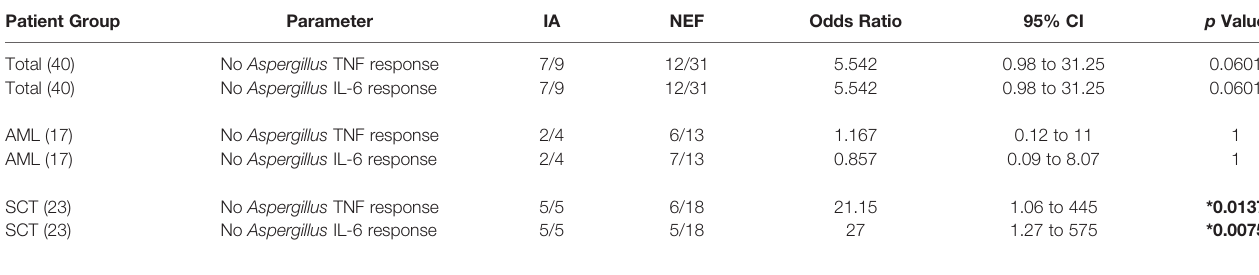
ThisdatawasproducedfromacontingencymultivariatestatisticalanalysisofpatientPBMCfunctionalassayresultsasdisplayedin Figure2 .IArepresentsprobableIA.NEFrepresentsno evidenceoffungaldisease.Fisher ’ sexacttestwasusedtoidentifystatisticalsigni fi cance.Wheretwovariableswereexamined,statisticalsigni fi cancewassetat*p<0.05;signi fi cantvalues are highlighted